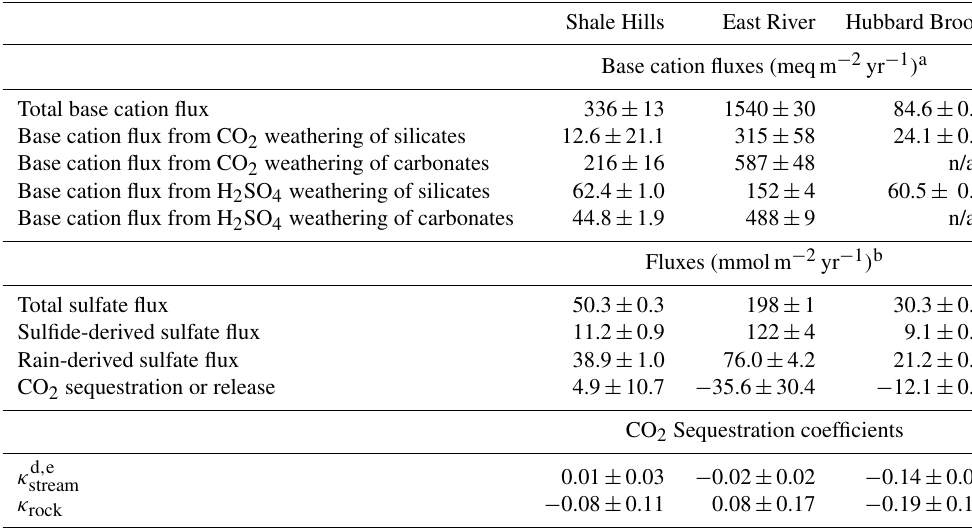
Table 1. Fluxes of SO 2 − , cations, and CO 2 . n/a stands for “not 4